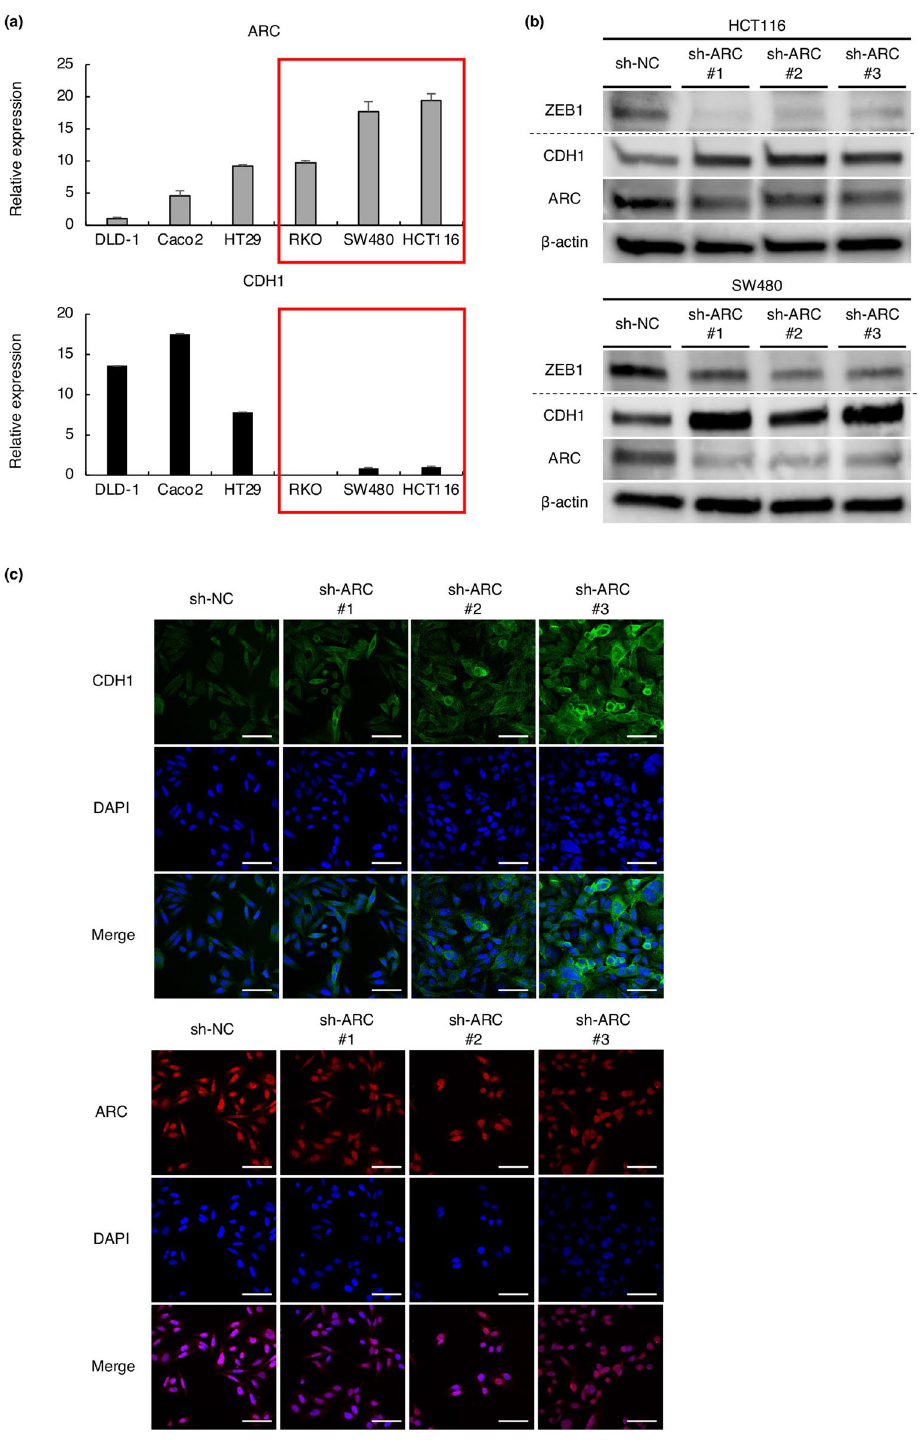
Figure 3. Association between the neuronal gene ARC and EMT. ( a ) ARC and CDH1 expression in six CRC cell lines (DLD-1, Caco2, HT29, RKO, SW480, and HCT116). Red boxes indicate cell lines with relatively high expression of ARC. All experiments were conducted in triplicate. Error bars show standard errors of the mean. ( b ) Alteration of CDH1 and ZEB1 expression by knockdown of ARC using shRNAs in western blot analysis. Results of ZEB1 were shown from different membranes using the same samples. Quantification of blots and full-length blots are presented in Supplementary Fig. 6b, c and Supplementary Fig. 11a, respectively. ( c ) Immunocytochemistry of CDH1 and ARC in SW480 cells expressing sh-NC and sh-ARC. Experiments were conducted in triplicate. Scale bars indicate 50 µm. EMT epithelial–mesenchymal transition, CRC colorectal cancer, Sh short hairpin, NC negative